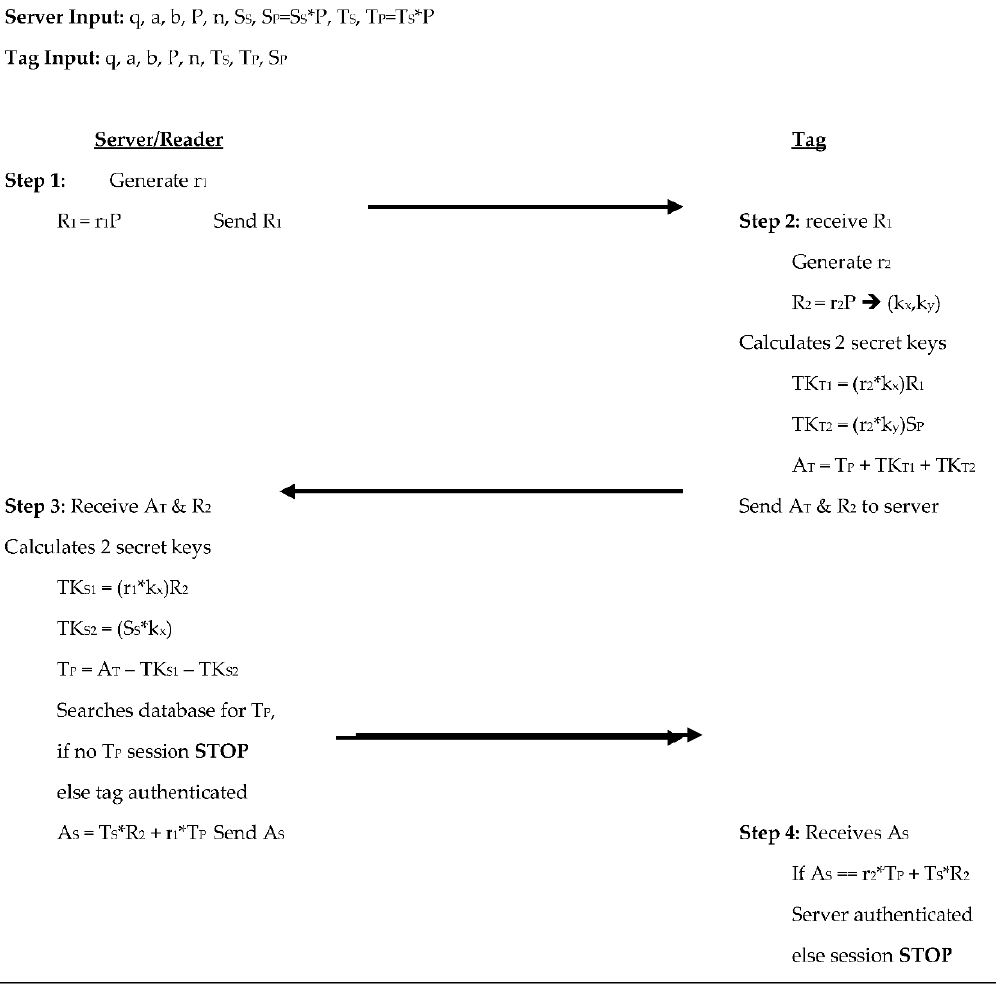
Figure 6. Authentication phases for Zhao [15].